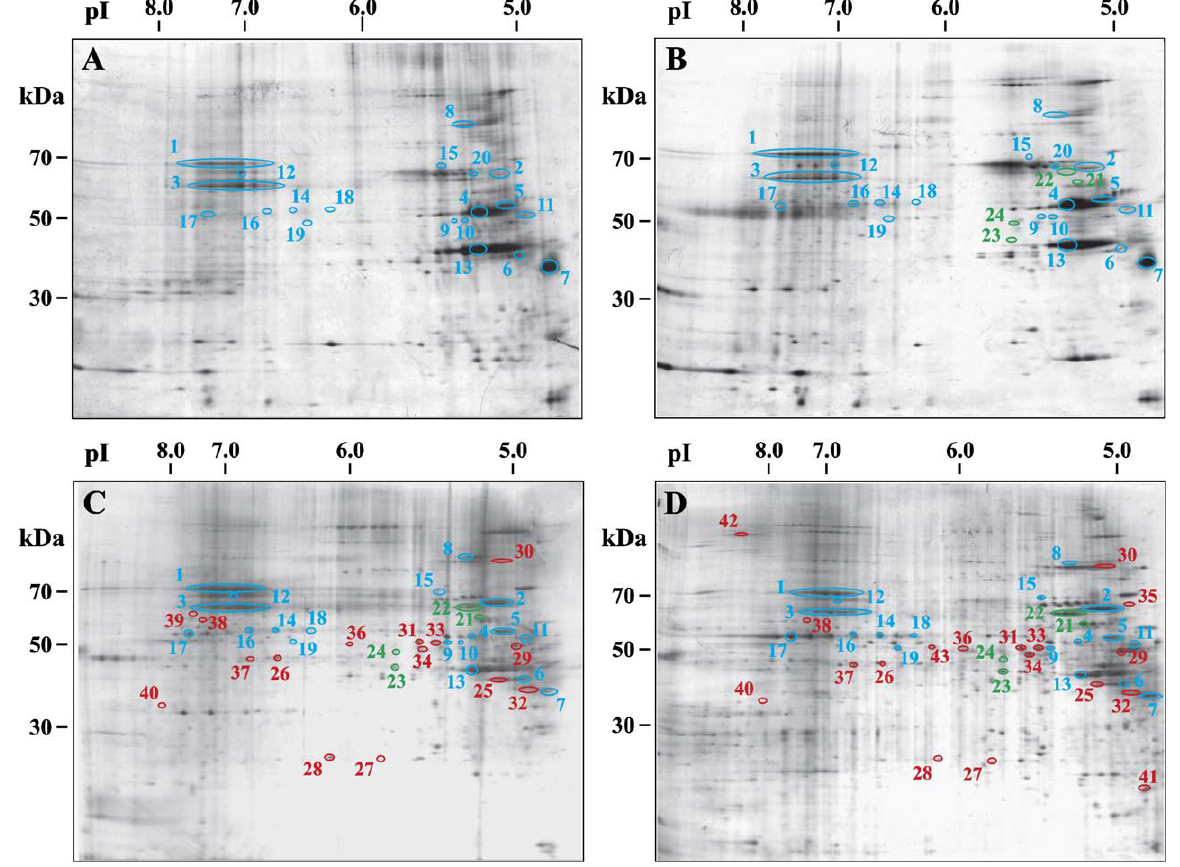
Fig. 1. Representative 2D silver-stained gel maps of the NM proteins extracted from different bladder tissues. (A) HU, (B) NT, (C) and (D) TCC at different clinical stages (pT2 and pT4, respectively). The 43 proteins identified are highlighted in circles and are marked with the same number used in Tables. The color denotes the tissue in which the spots have been detected first (blue HU, green NT, red TCC). to low abundant spots occurring at levels below